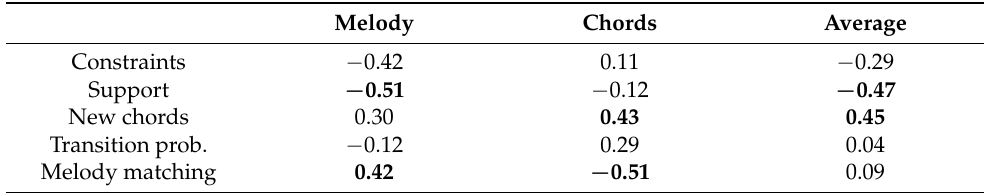
Figure 3. Two example cross-harmonizations with “Solar” as Song A and ( a ) Giant Steps and ( b ) Time Remembered as Song B. Melody mismatches are indicated. In ( a ), melody mismatches are very often, in contrast to ( b ). Table 5. Correlation analysis between ratings and re-harmonization features. Noteworthy correlation values are in dicated in